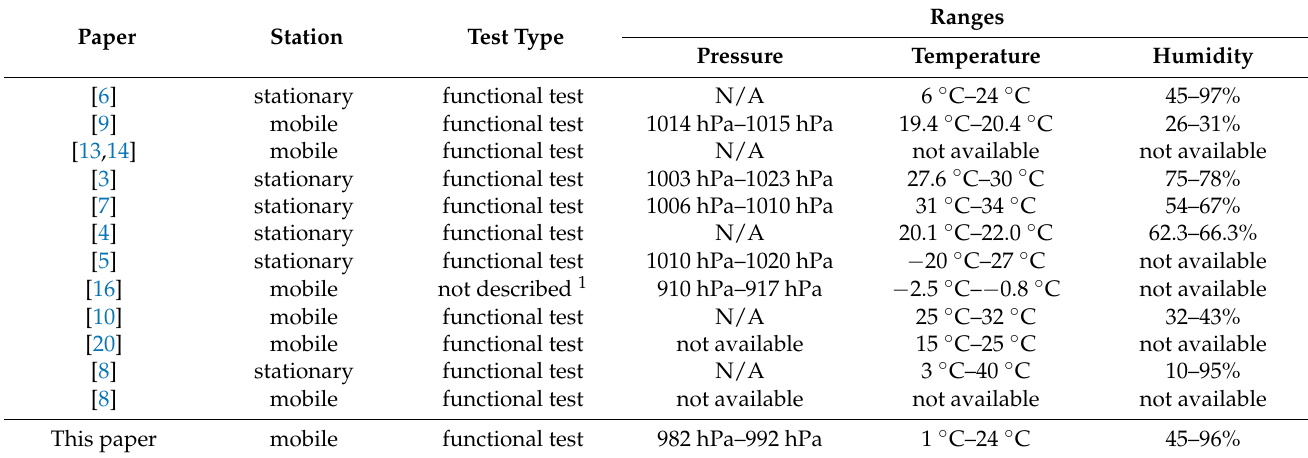
Table 6. Experiments carried out in related work.